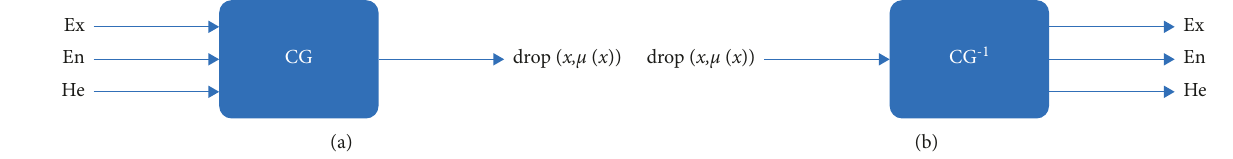
Figure 3: Cloud generator: (a) forwarding cloud generator and (b) reverse cloud generator.